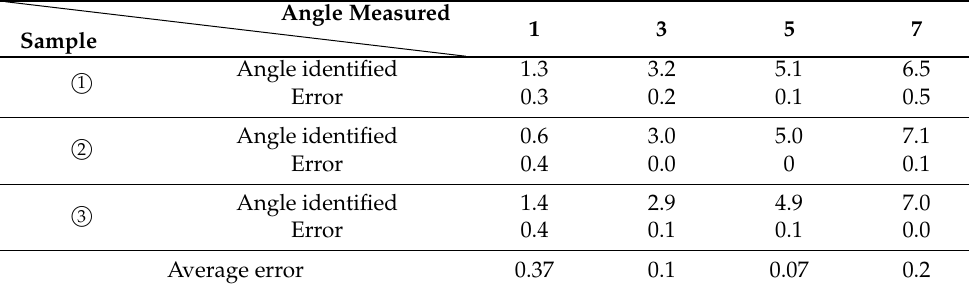
Figure 15. Identification results of a four-bolted connection.